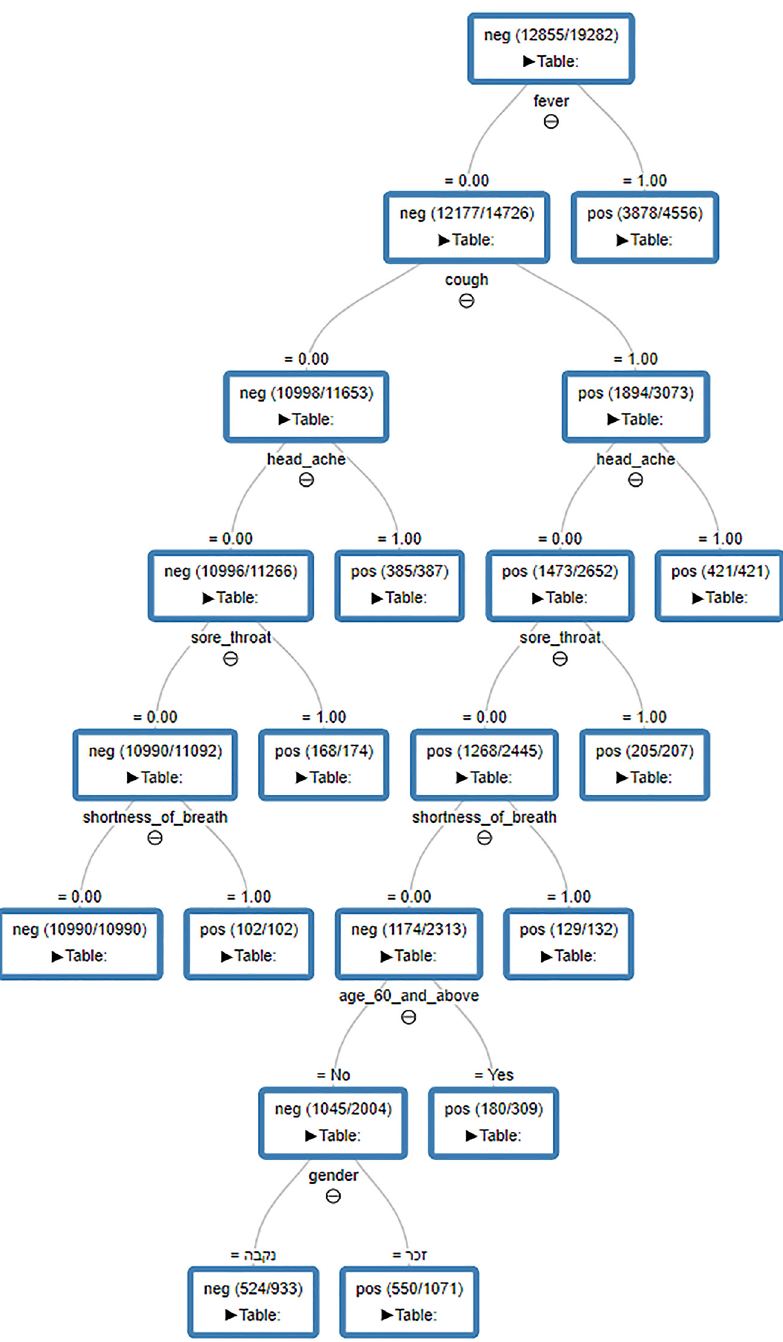
Figure 1: The decision